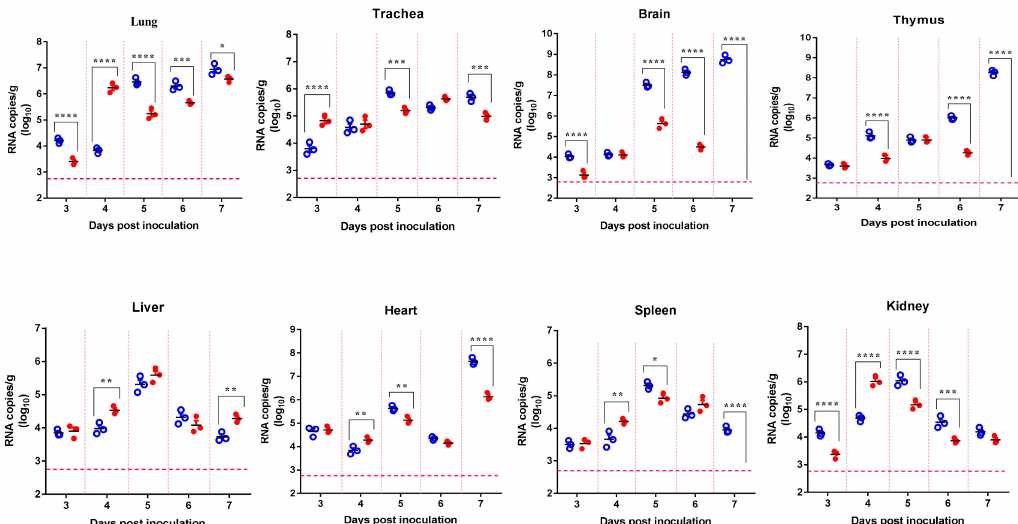
Figure 1. Tissue distribution of Japanese encephalitis virus (JEV) RNA in mice infected by the intranasal route. Four-week-old mice were intranasally (i.n.) inoculated with 10 6.0 plaque-forming units (pfu)/50 µ L of SCYA201201 or SA14-14-2 JEV virus. The viral RNA load was measured using real-time RT-PCR in each mouse tissue collected at 3, 4, 5, 6, and 7 days post-infection (dpi) and expressed as RNA copies per gram (Mean ± SEM) ( ○ represent the SCYA201201 strain, and ● represent the SA14-14-2 strain). The horizontal dotted lines indicate the limit of detection (* P ˂ 0.05, ** P ˂ 0.01, *** P ˂ 0.001, and **** P ˂ 0.0001).